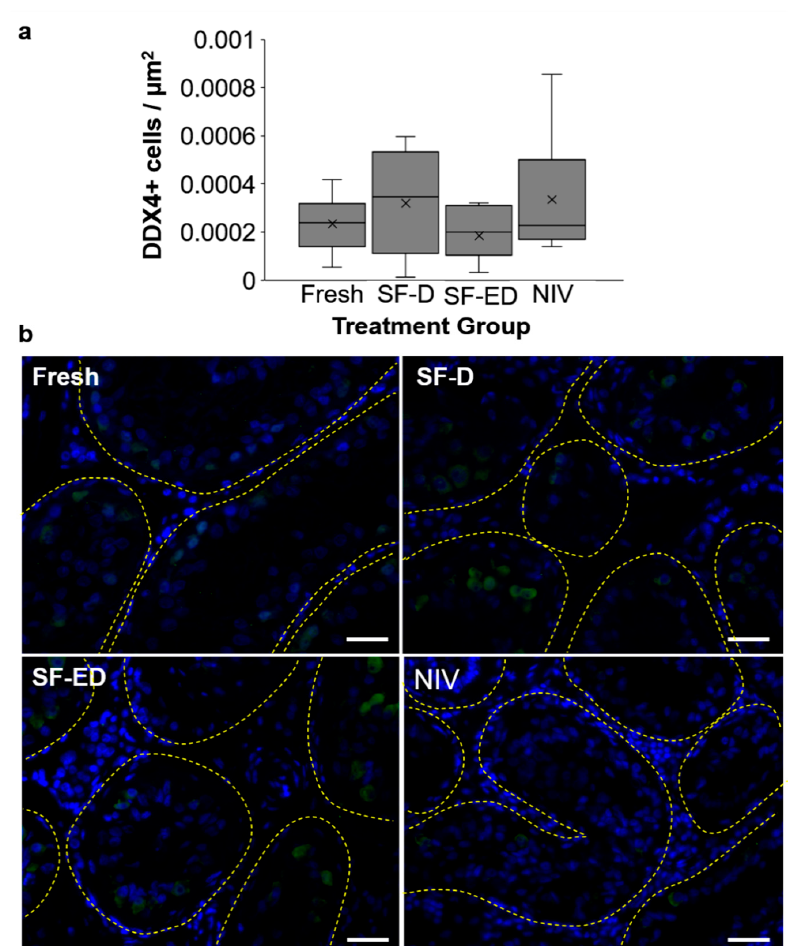
Figure 3. Grey wolf testicular tissue preservation, with ( a ) density germ cell marker DDX4 positive cells in grey wolf tissues following slow freezing in DMSO alone (SF-D), or in ethylene glycol and DMSO (SF-ED), or needle immersion vitrification (NIV) compared with fresh controls (n = 7 wolves), and ( b ) representative images of DDX4+ cells (green) with nuclear DAPI (blue) counterstain. Yellow line denotes outline of seminiferous tubules, and white bar = 50 µm. Reprinted with the permission from ref. [168]. Copyright 2021